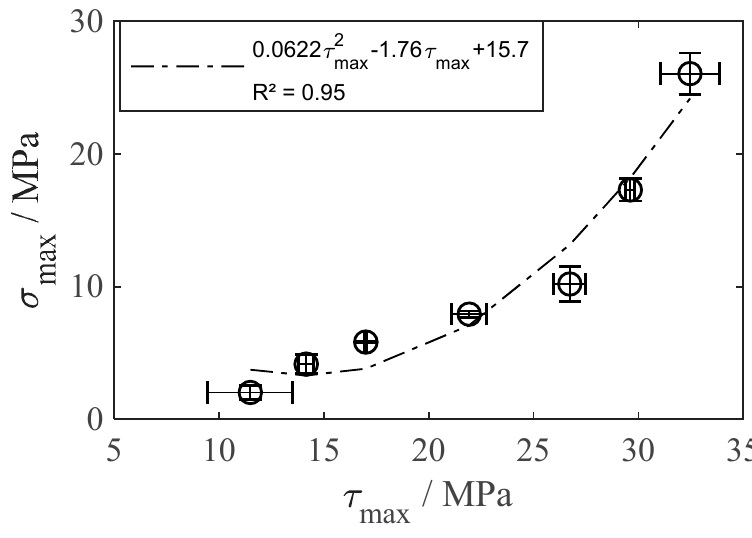
Figure 10. Interlaminar tensile strength σ max in relation to shear strength τ max , mean values ± 1 SD. The fractured surfaces of the shear- and tensile-tested specimens are depicted in Figure 11.